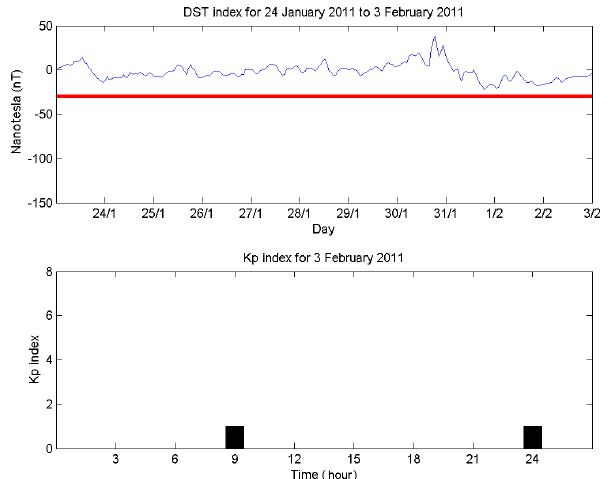
Figure 3. The D st index for 24 January to 3 February and the K p index for the normal period on 3 February 2011.